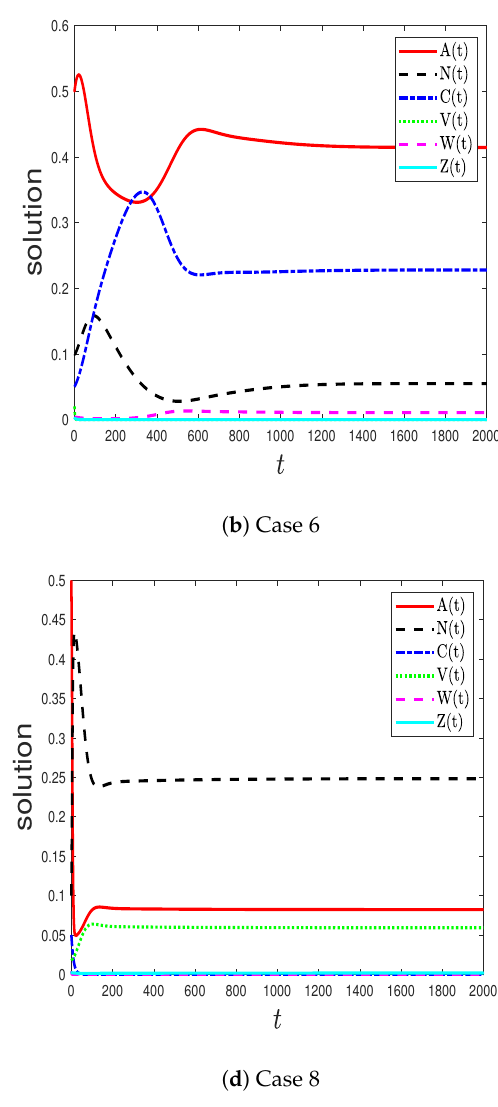
Figure 2. The numerical simulations of system (1) for cases 5–8. The figures exhibit the stability of ( a ) the cancer-CTL steady state E 4 : η 1 = 0.03, η 2 = 0.1, η 4 = 0.9, η 5 = 0.3, κ 1 = 0.1, κ 2 = 0.0005, κ 3 = 0.5, κ 4 = 0.0005, κ 5 = 0.07, ( b ) the virus-free steady state E 5 : η 1 = 0.1, η 2 = 0.1, η 4 = 0.9, η 5 = 0.3, κ 1 = 0.01, κ 2 = 0.0005, κ 3 = 0.5, κ 4 = 0.0005, κ 5 = 0.07, ( c ) the immune-free steady state E 6 : η 1 = 0.3, η 2 = 0.2, η 4 = 0.03, η 5 = 0.3, κ 1 = 0.02, κ 2 = 0.02, κ 3 = 0.0005, κ 4 = 0.9, κ 5 = 0.07, and ( d ) the cancer-free steady state E 7 : η 1 = 0.9, η 2 = 0.03, η 4 = 0.03, η 5 = 1.7, κ 1 = 0.001, κ 2 = 0.08, κ 3 = 0.01, κ 4 = 0.9, κ 5 =